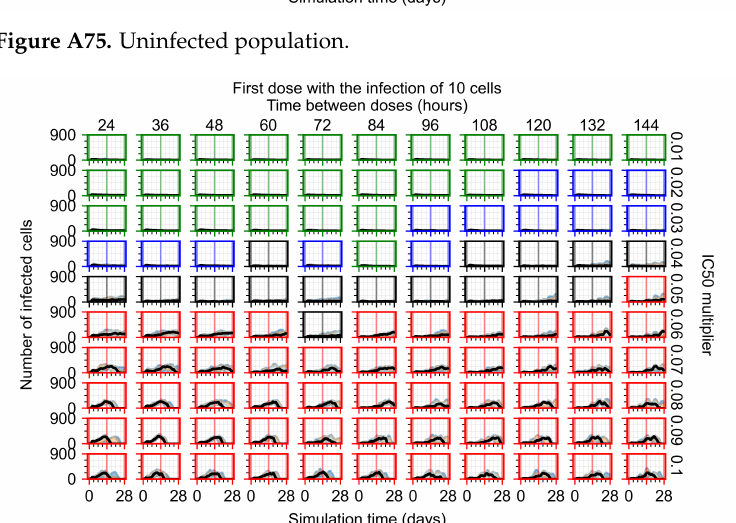
Figure A76. Infected (eclipse phase)